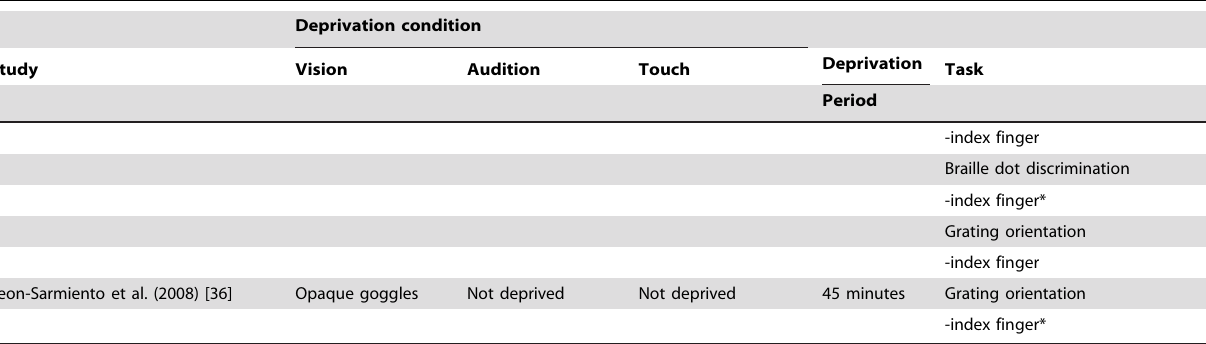
(Figure 5): non-deprived (10 blocks, p =0.711), repeatedly tested (10 blocks, p =0.941), passively stimulated (6 blocks, p =0.677),